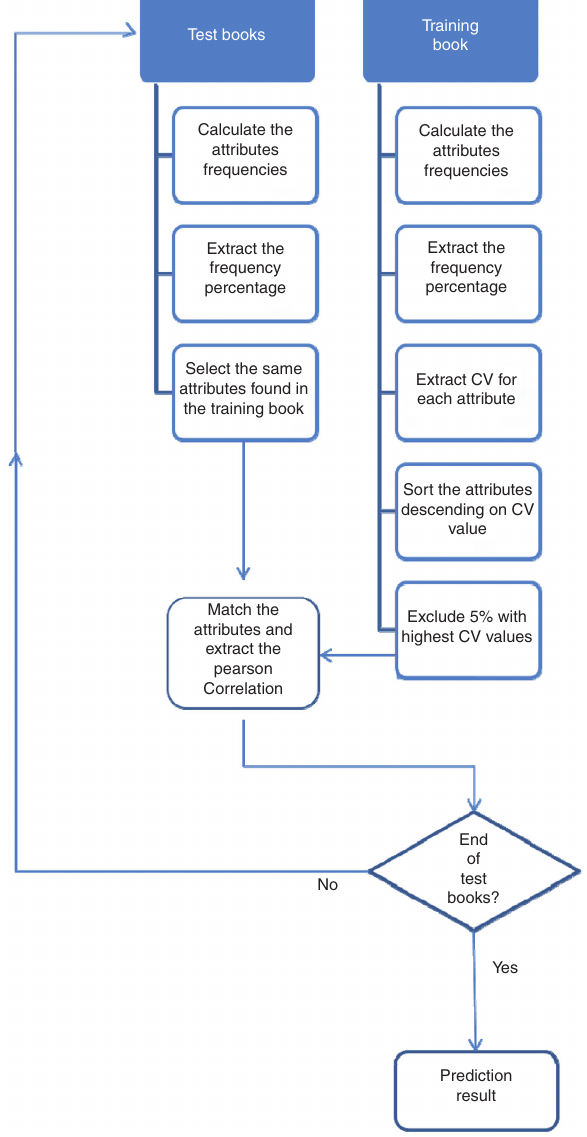
Figure 1: Diagram Summarizing the SABA Algorithm